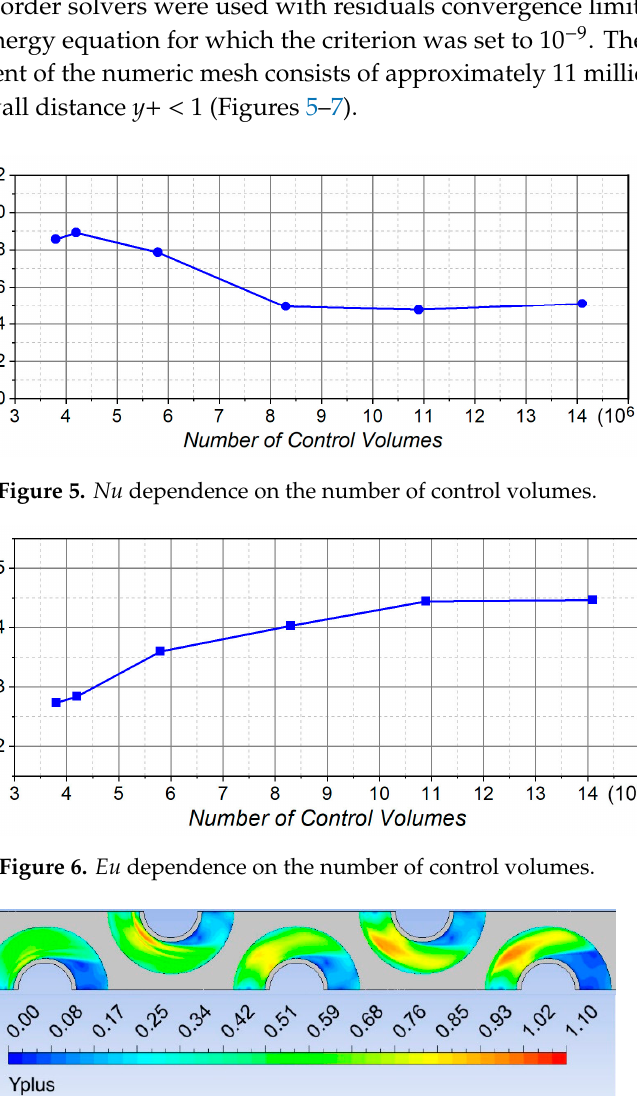
Figure 7. Dimensionless wall distance y + .